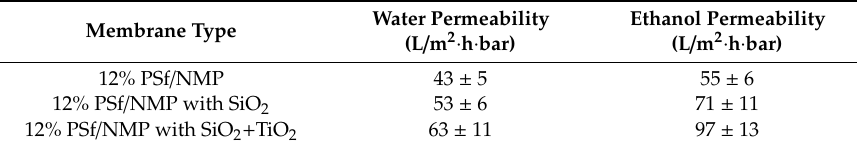
Table 1. Permeability of polysulfone composite membranes.